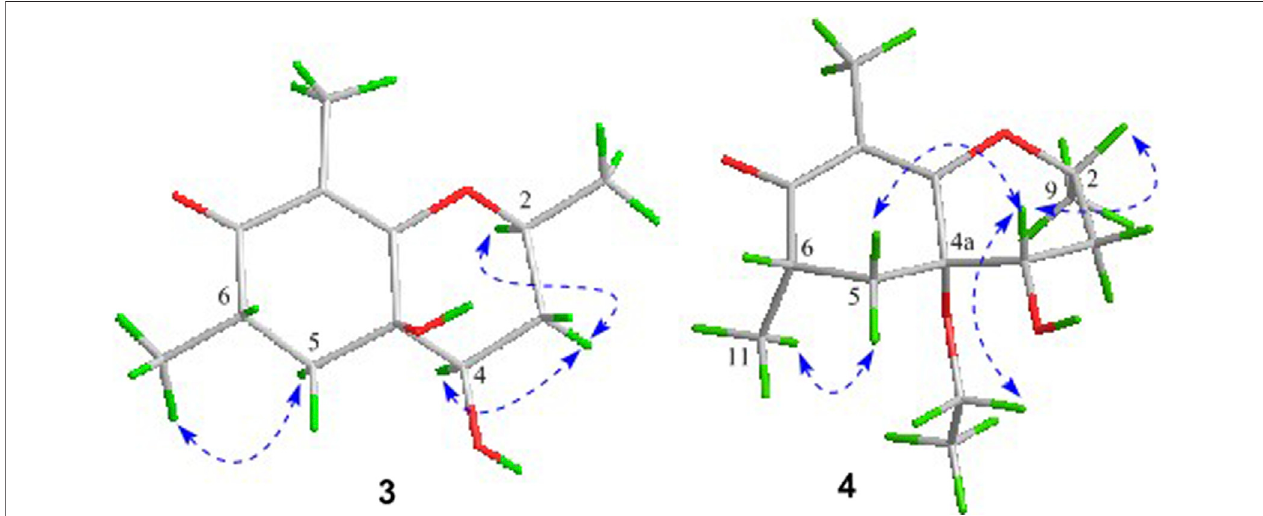
FIGURE 6 | Key NOESY correlations of compounds 3 and